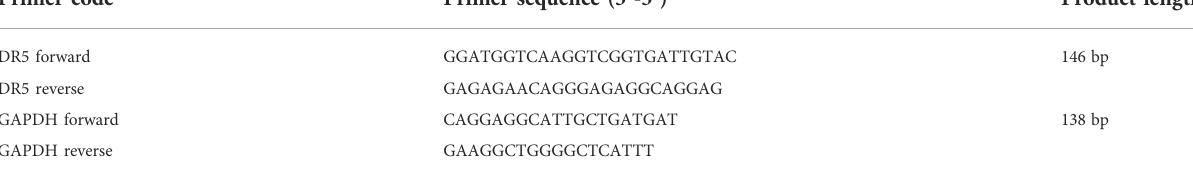
TABLE 1 List of primer sequences for quantitative PCR.